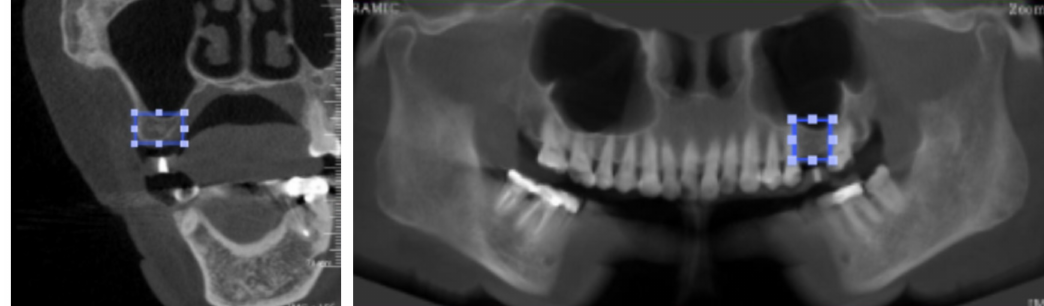
Figure 2. Image labelling in both cross-sectional and panoramic images.